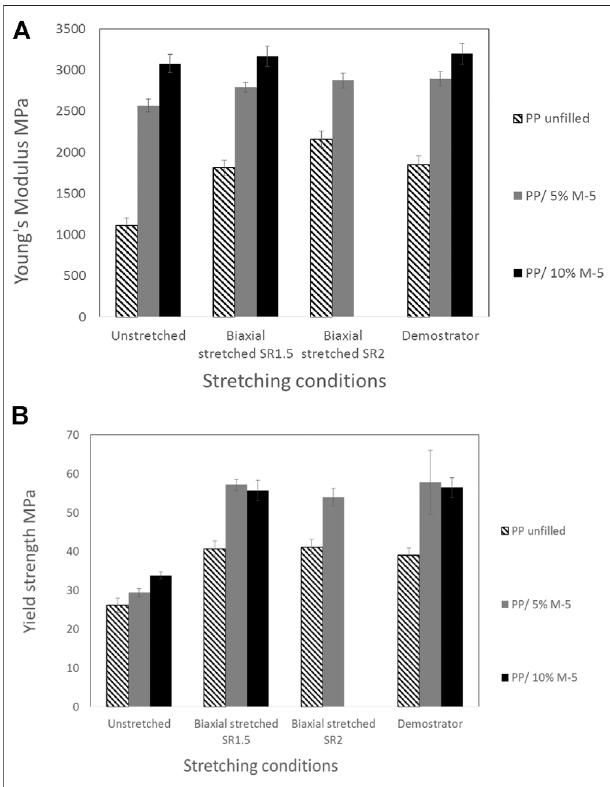
FIGURE 2 | Effect of biaxial stretching on (A) Young ’ s Modulus and (B) yield strength of un fi lled PP and PP/GNP composites.